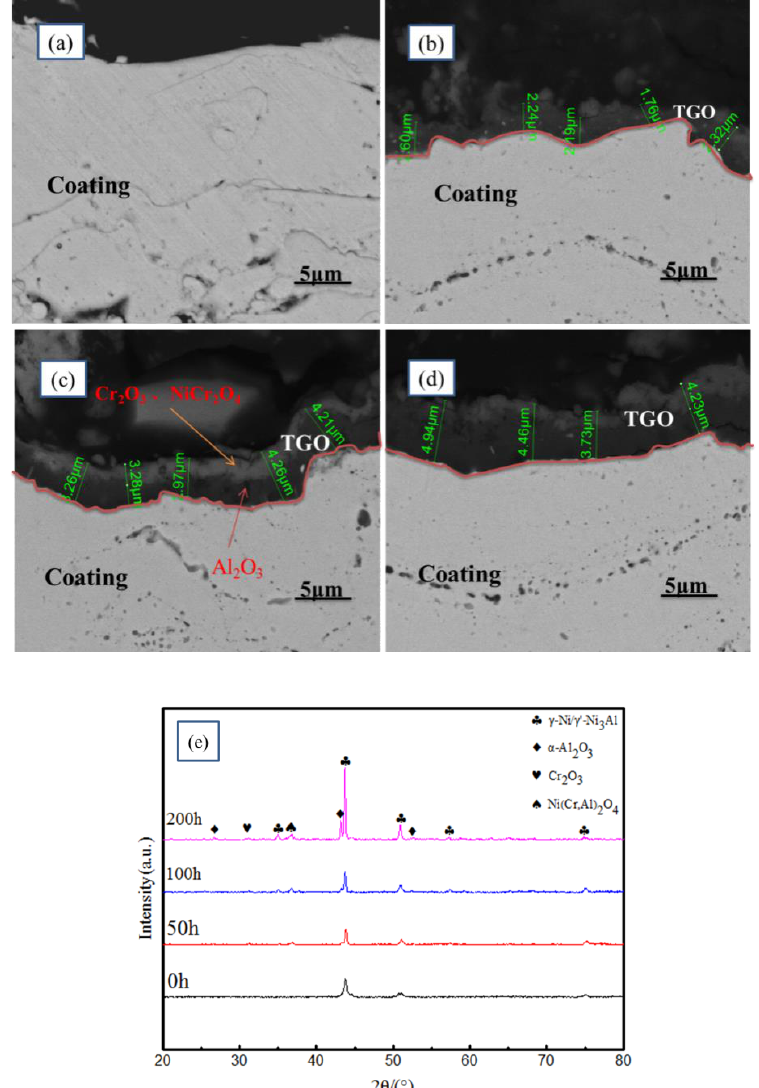
Figure 2. BSE images and XRD patterns of NiCoCrAlY coating after static oxidation at 1100 °C for different time: ( a ) 0 h; ( b ) 50 h; ( c ) 100 h; ( d ) 200 h; ( e ) XRD patterns.